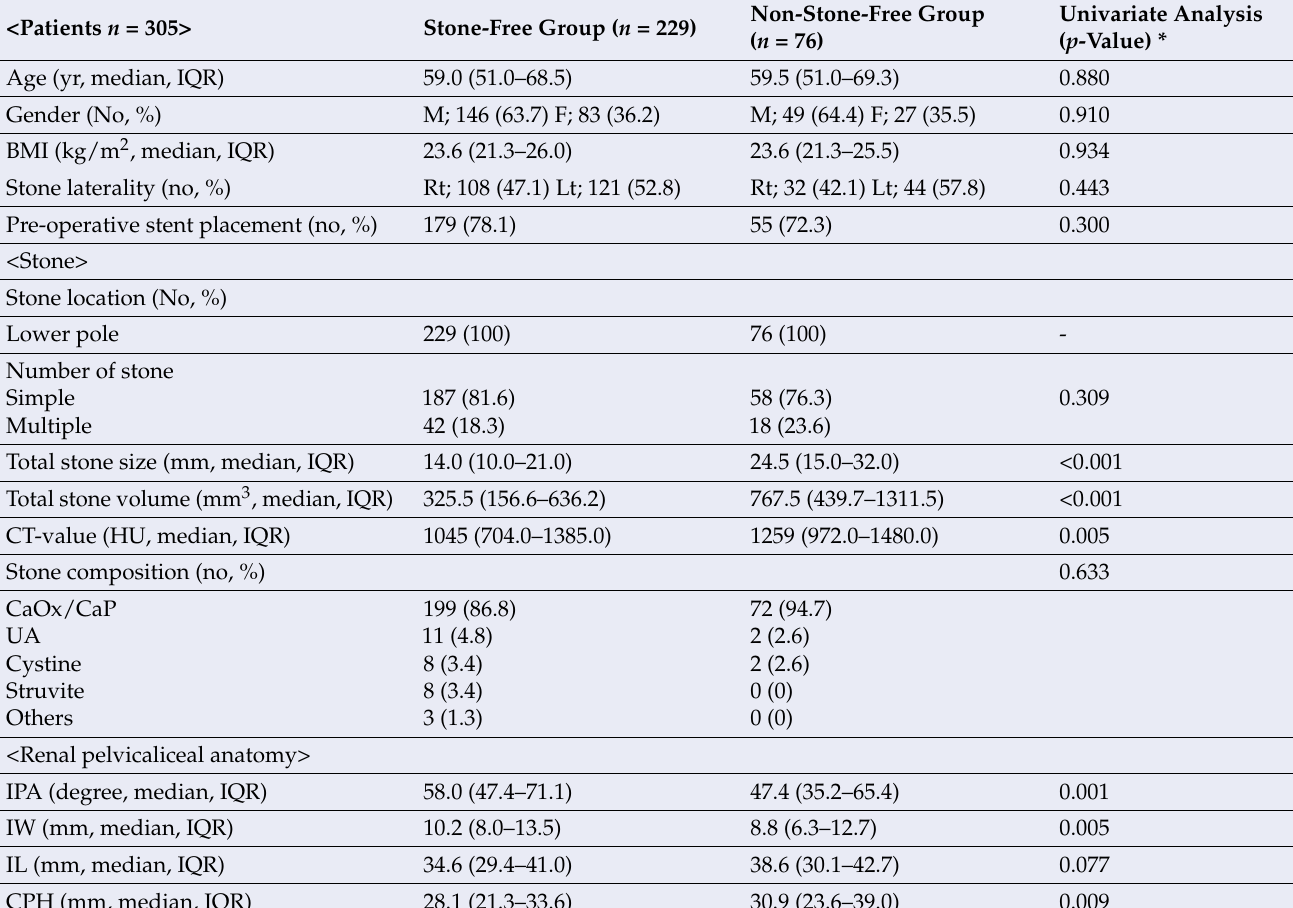
Table 1. Patients, stone demographics, and pelvicalyceal anatomy in stone-free